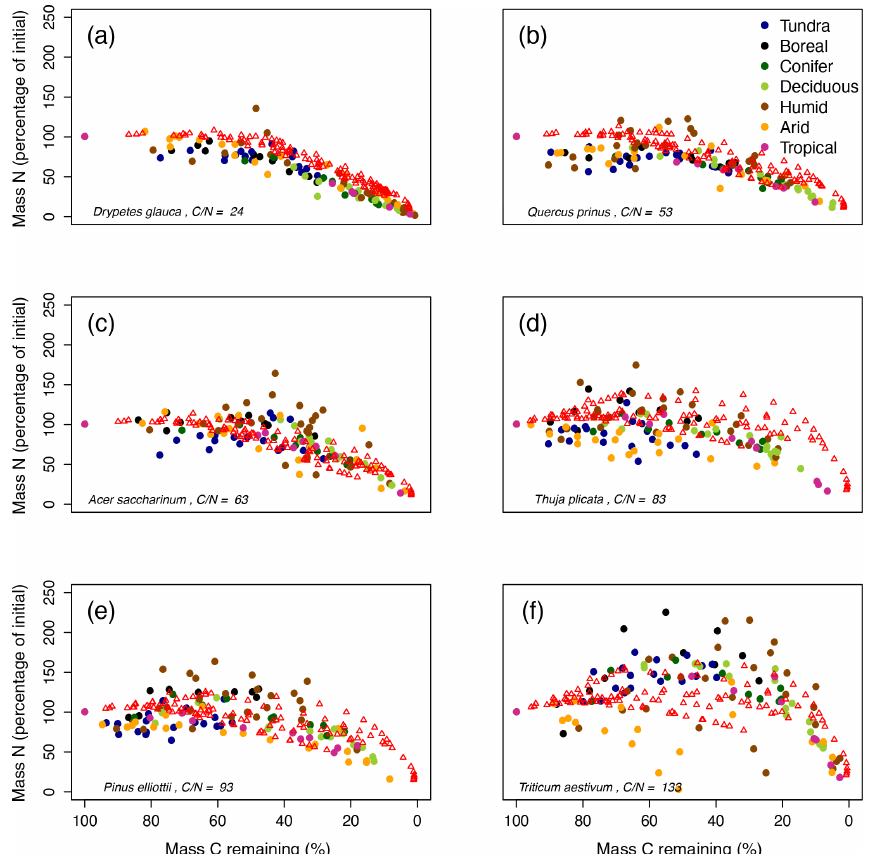
Figure 4. MIMICS-CN simulations of immobilization–mineralization thresholds across litters of different quality. Litter quality (in terms of C:N and lignin content) decreases from upper-left panel to lower-right panel. Red triangles show model simulations of C losses vs. N losses from litterbags in the LIDET study. Colored dots show observed C vs. N losses across biomes (Parton et al., 2007).